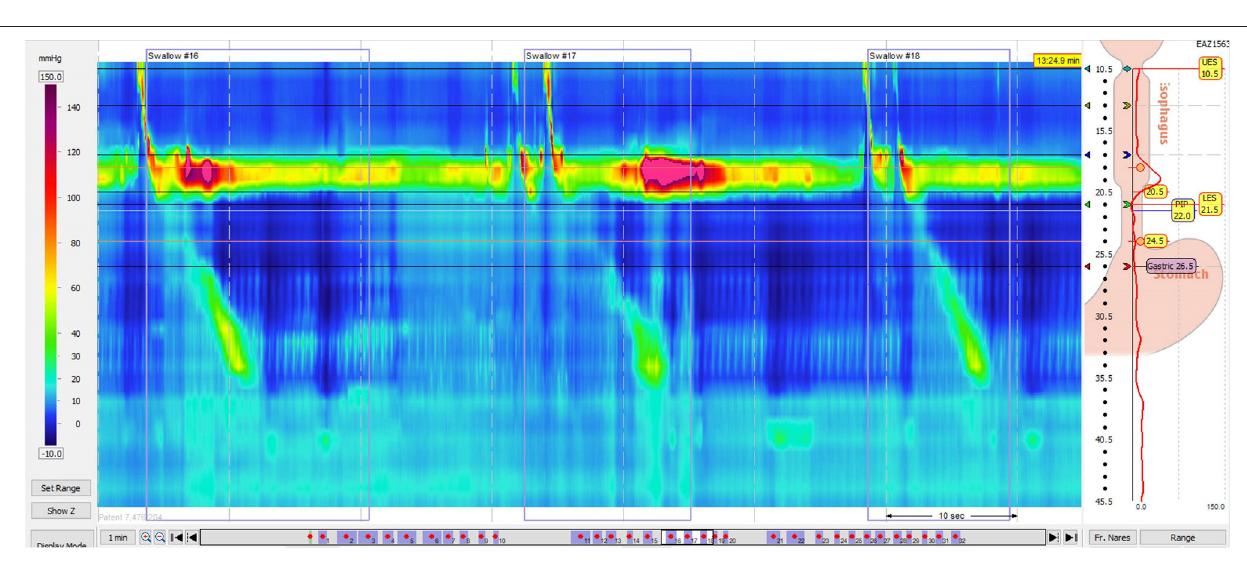
FIGURE 2 | High resolution manometry in eosinophilic esophagitis showing weak peristalsis on wet swallows in a child. Reprinted with permission from Dr Rachel